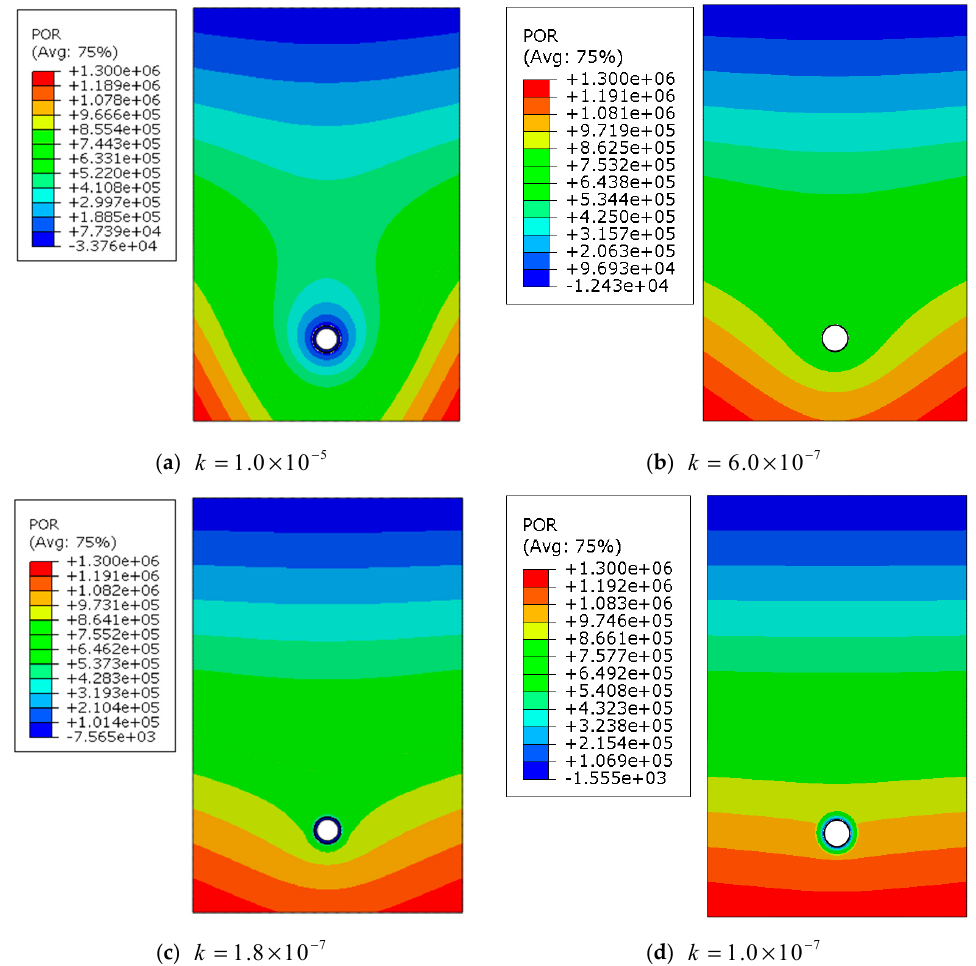
Figure 12. Pore pressure distribution clouds of the surrounding rock for the four working condi- tions.